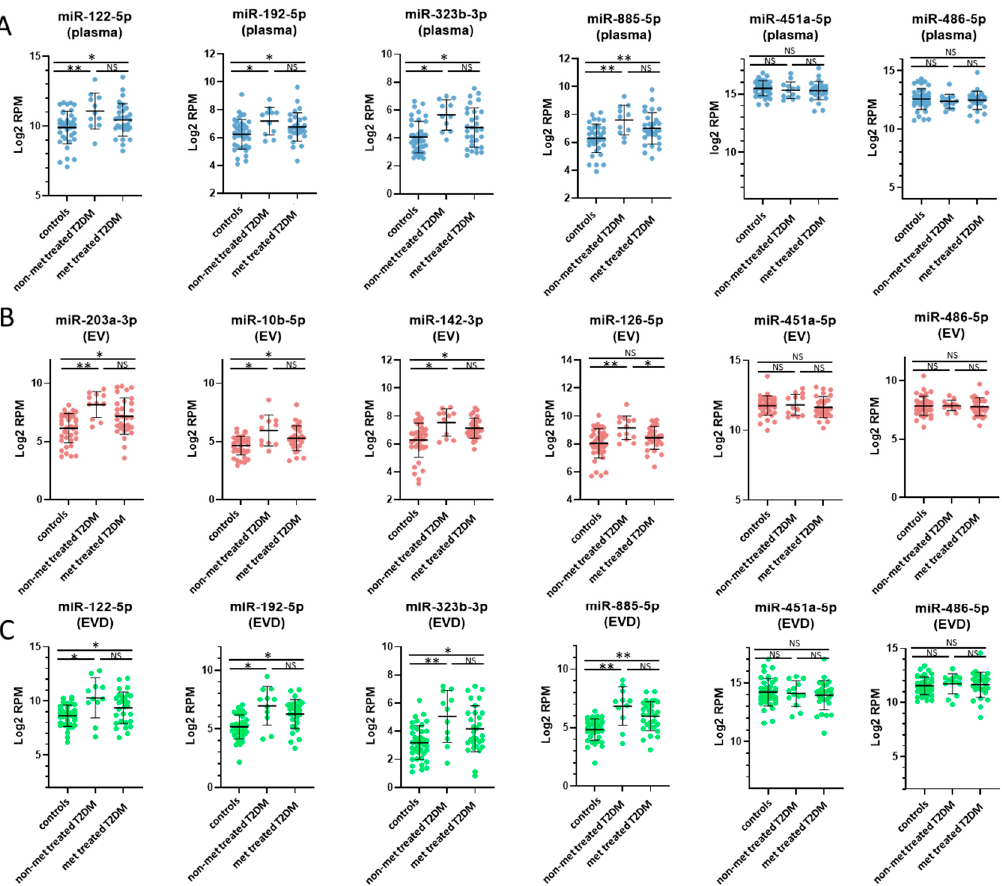
Figure 4. Selected miRNAs with concentration changes between controls and non-metformin (non-met) treated, and metformin-treated (met treated) T2DM. Plots of selected miRNAs showing concertation di ff erences between controls, non-metformin treated T2DM and metformin treated T2DM patients in plasma, EV and EV-depleted samples. Plasma miRNA plots ( A ) are depicted in blue, EV miRNA plots ( B ) are depicted in red, and EV-depleted miRNA plots ( C ) are depicted in green. The values are in log2 RPM (log2 transformed reads per million), with each dot representing a patient sample. The invariant miRNAs, miR-451a-5p and miR-485-5p, are also shown. Statistically significant results are designated by asterisks (* p < 0.05, ** p < 0.01), and non-significant results are designated as ‘NS’.